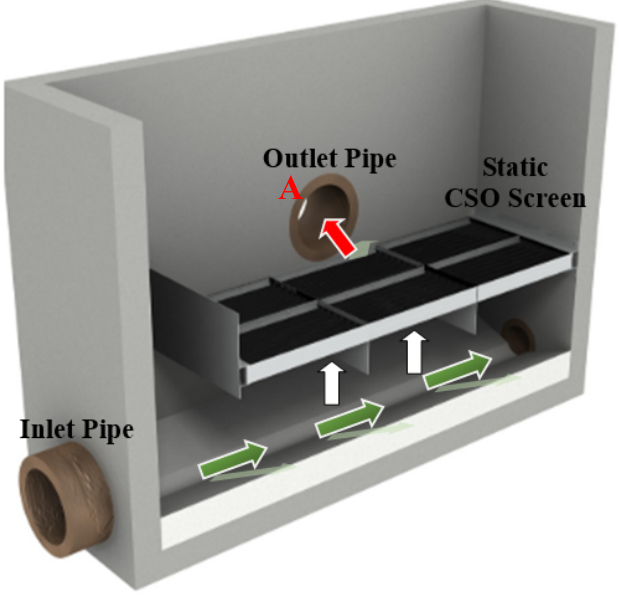
Figure 1. Sectional internal view of a traditional combined sewer overflow (CSO) chamber (adapted from [15]).